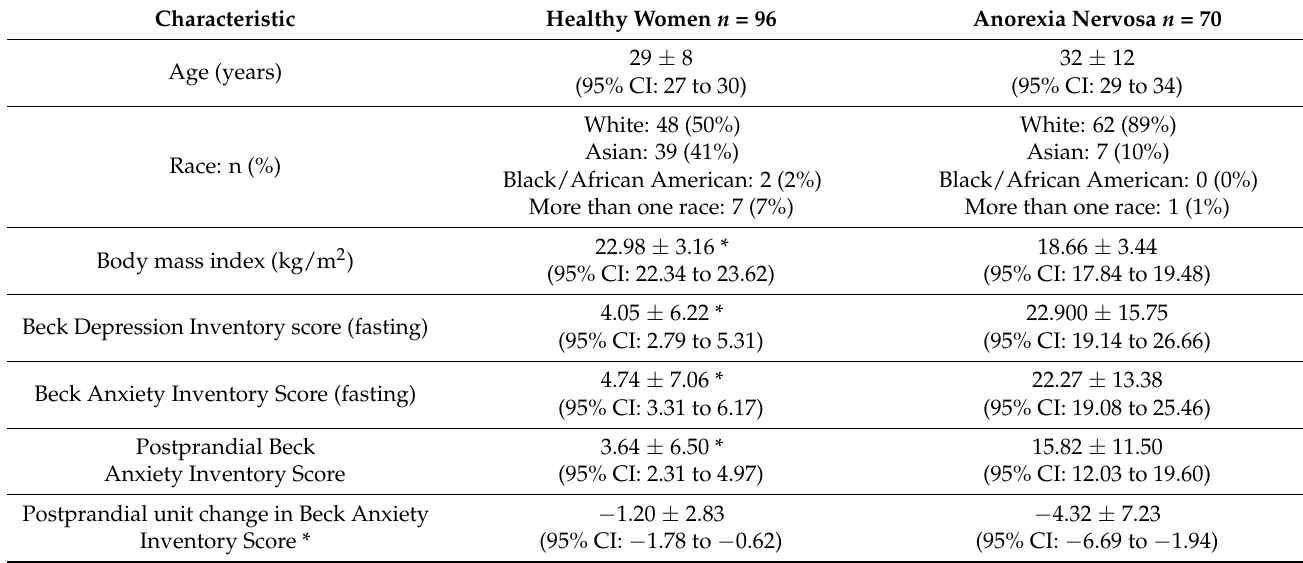
Table 1. Study participant